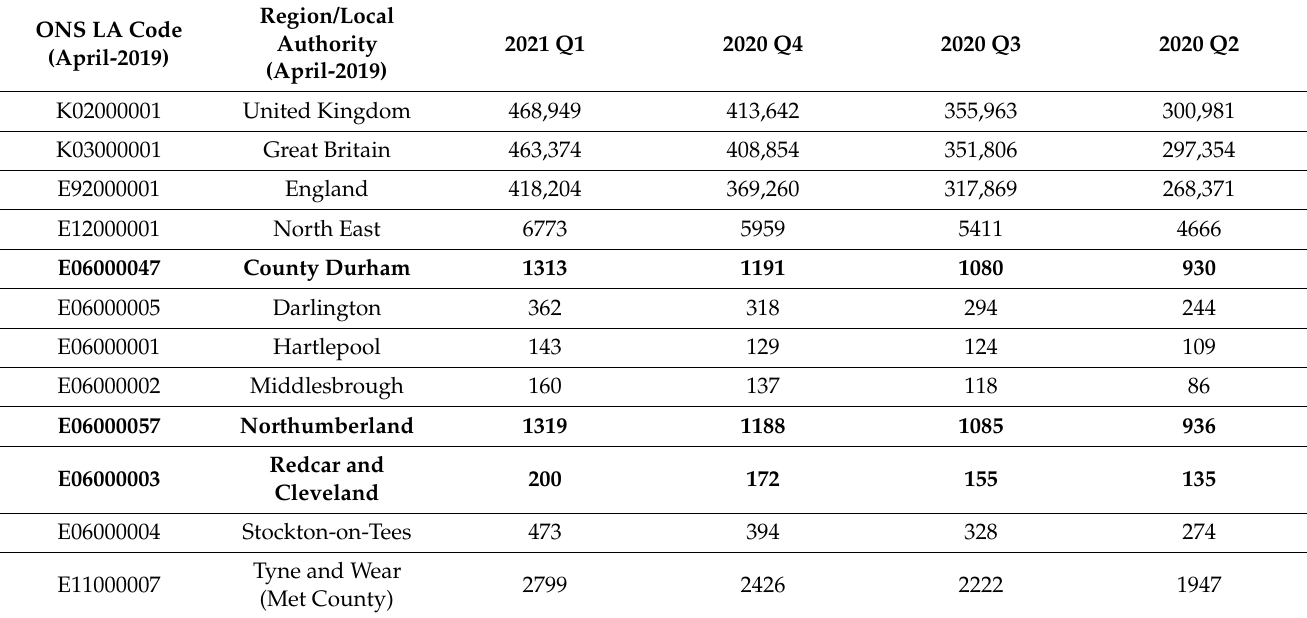
Table 2. Plug-in cars and light goods vehicles licensed at the end of quarter by upper and lower tier local authority 2, United Kingdom from 2011 Q4 (Part) [31].